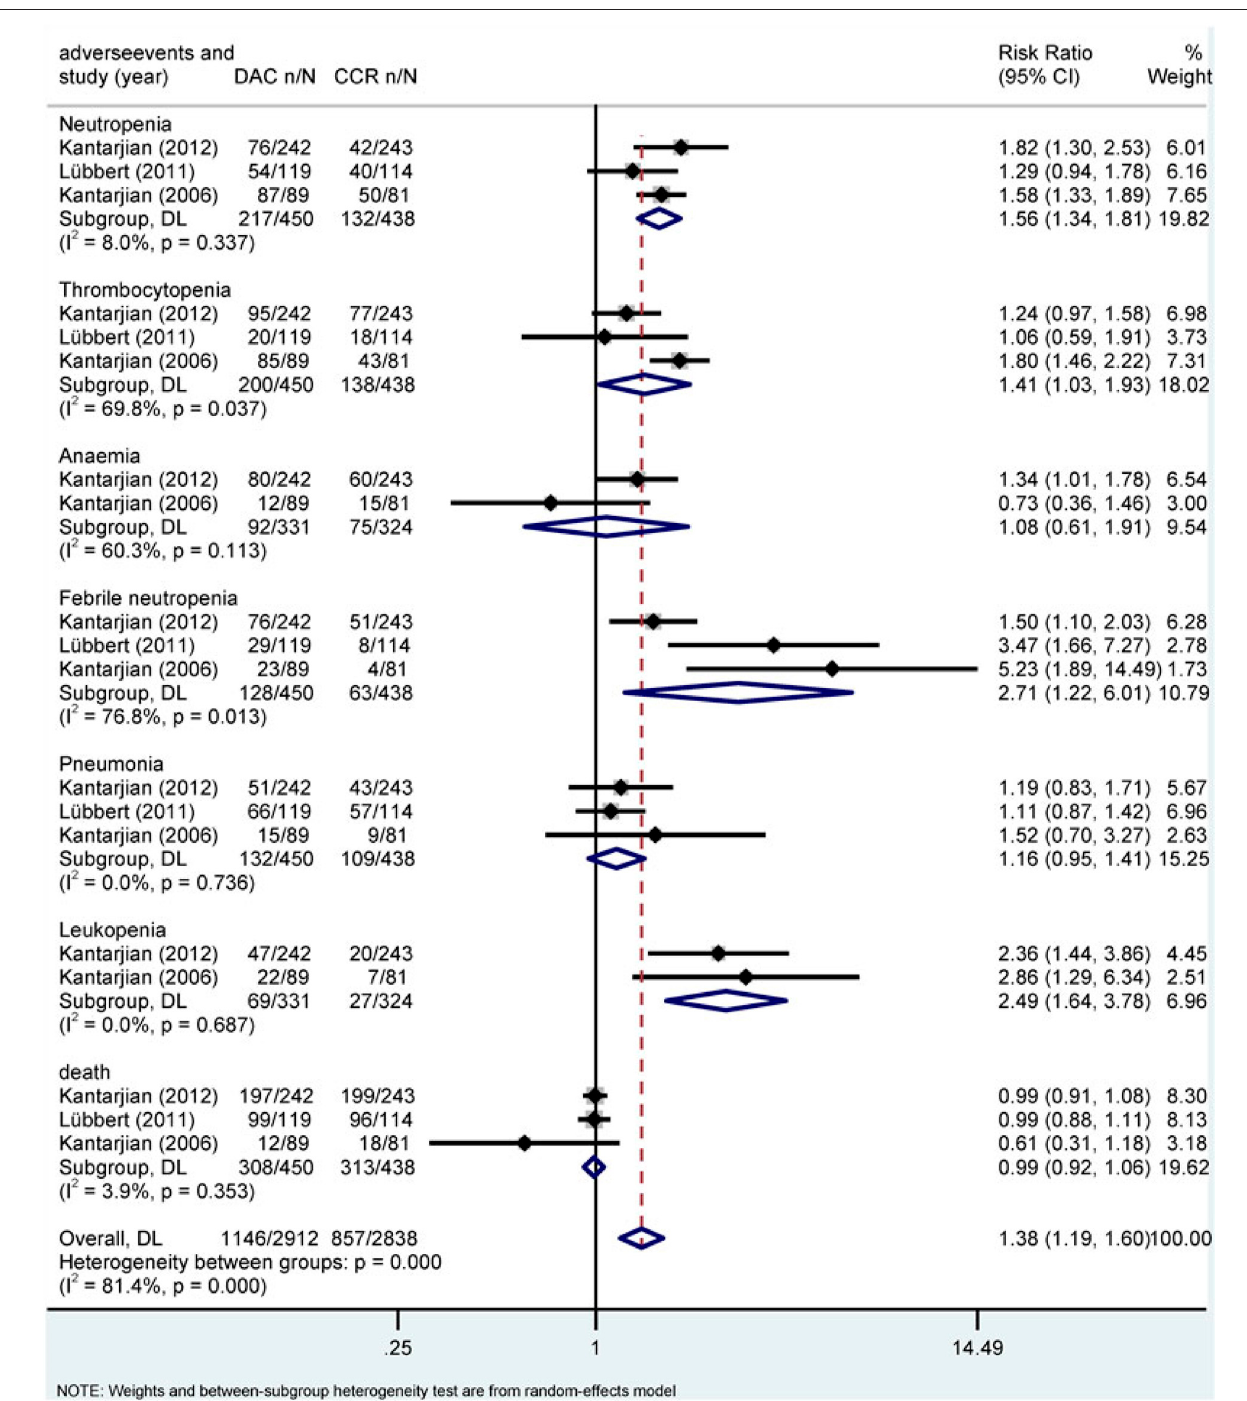
FIGURE 8 | Forest plot of grade 3/4 adverse events of decitabine vs. conventional care regimens (direct evidence-RR).